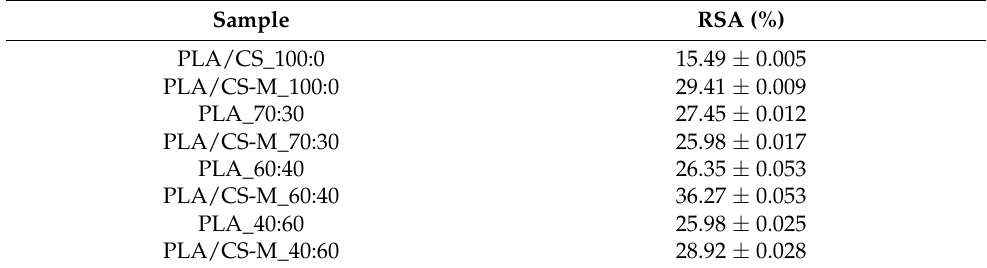
Table 5. Radical scavenging activity (RSA (%)) for PLA-based biocomposites and plasticized PLA samples. Reported values correspond to means ( ± standard